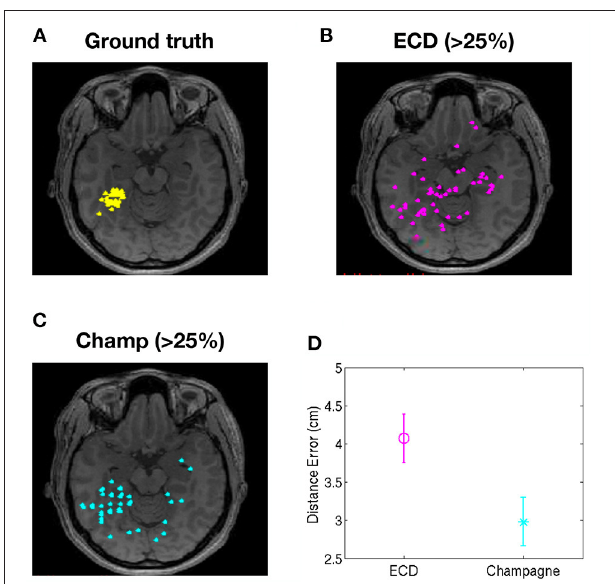
oscillations may supplant its role (Frauscher et al., 2017), it is